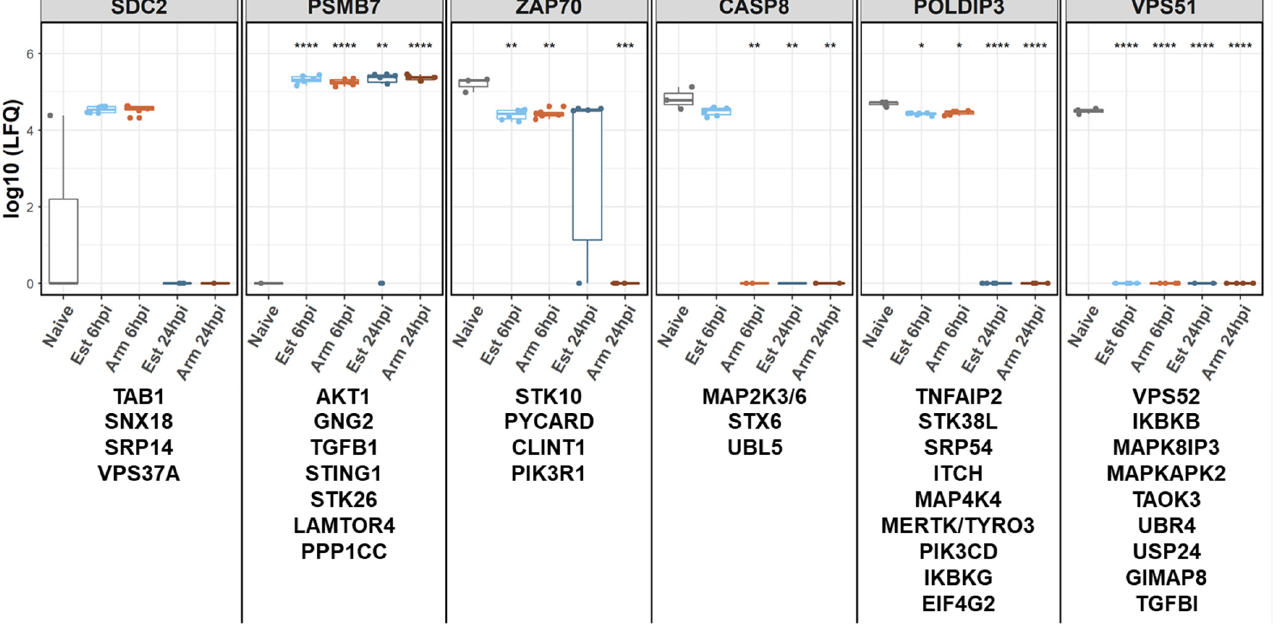
Figure 4. Expression profiles of porcine genes during African swine fever virus (ASFV) infection of monocyte-derived macrophages with Armenia 2008 (Arm) or Estonia 2014 (Est). Captions of the panels indicate one exemplary representative of the groups of host genes listed below the respective graphs sharing specific expression patterns. Asterisks indicate p -values of 0.05 (*), 0.01 (**), 0.001 (***), and 0.0001 (****).